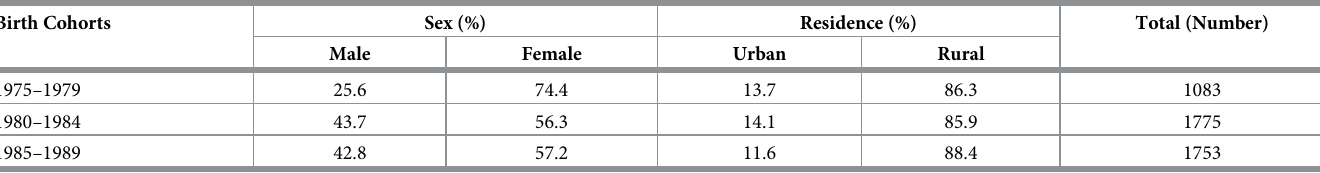
Table 2. Background characteristics of respondents, Oromia–Ethiopia. Birth Cohorts